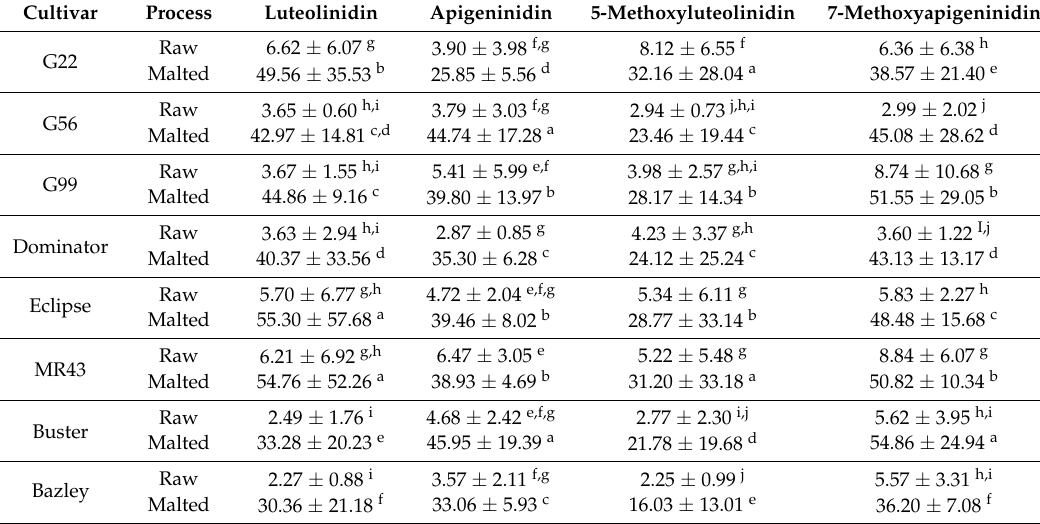
Table 6. Mean comparison for 3-deoxyanthocyanins ( µ g/g dry basis) in raw and malted grains of Australian sorghum cultivars. Values are means ± SD ( n =